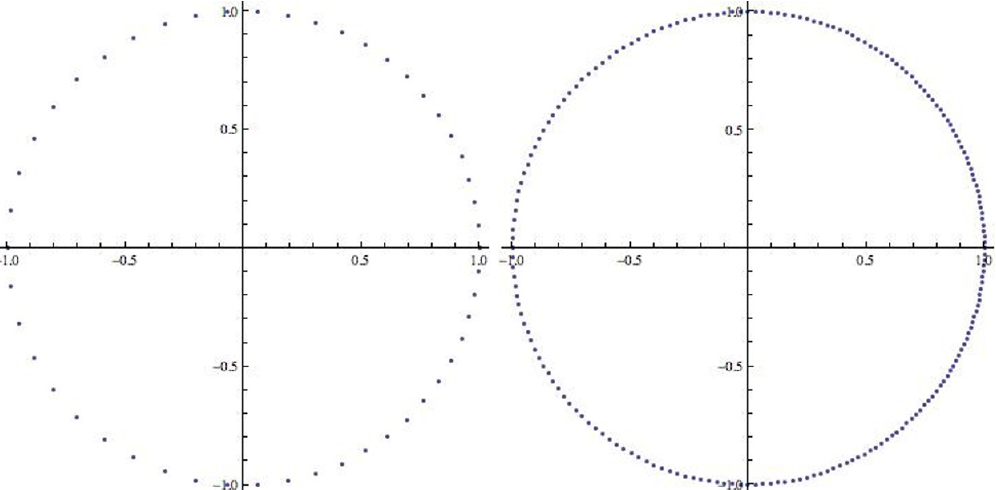
. For N equal 50 (Left) and 200 (Right) they are 8